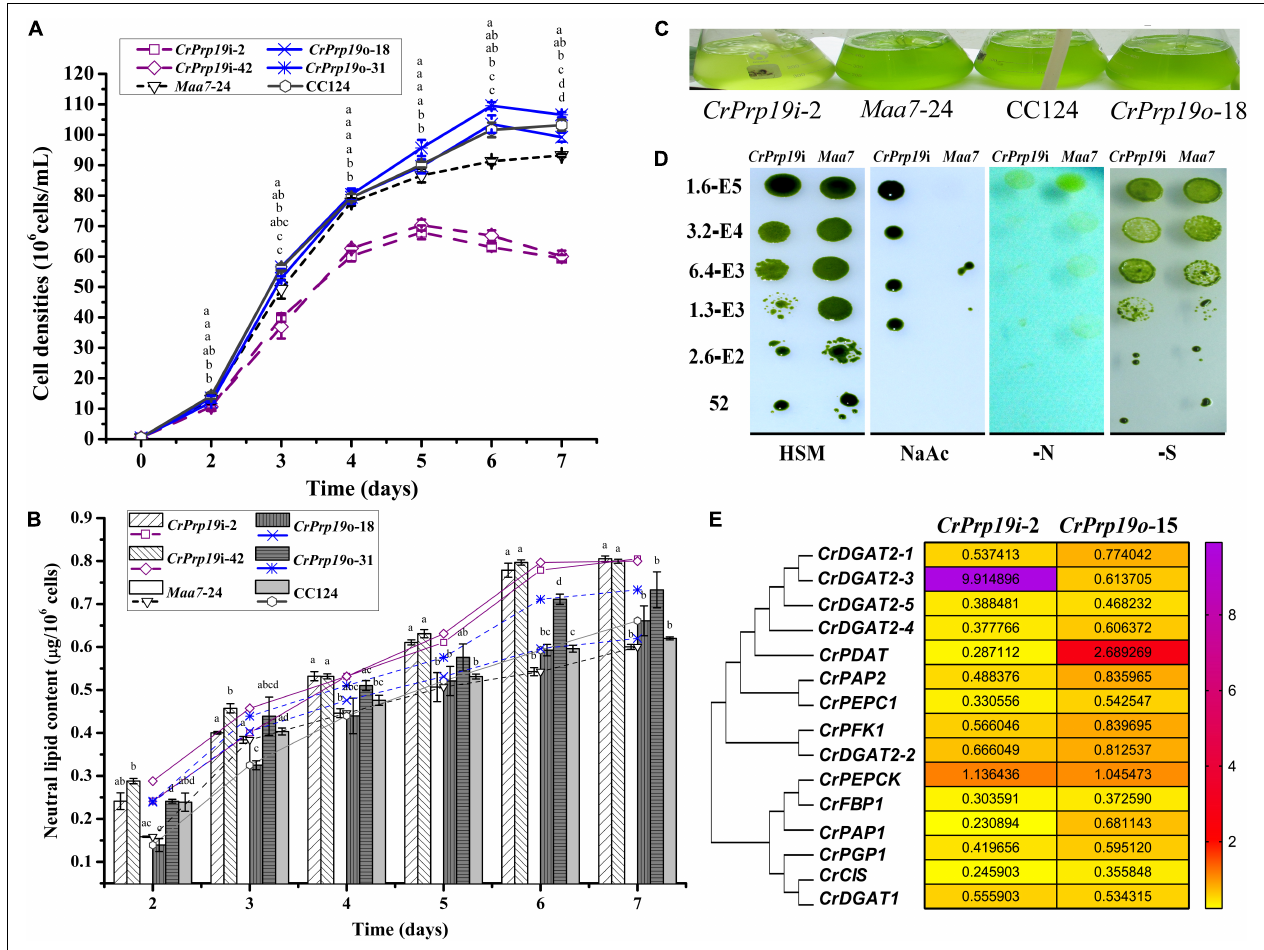
FIGURE 4 | CrPrp19 gene expression, cell growth, and NL contents of RNAi and overexpression transformants and their controls. NL contents were estimated by dividing cell density with NL concentration calculated by Nile Red fluorescent dye staining method. (A) Cell densities of CrPrp19 RNAi and overexpression lines and controls. The different letters above each point indicate that they were significantly different at p ≤ 0.05 according to one-way ANOVA. (B) NL contents of CrPrp19 RNAi and overexpression lines and controls. The different letters of each column indicate that they were significantly different at p ≤ 0.05 according to one-way ANOVA. (C) Aerated cultures of CrPrp19 RNAi and overexpression transformants and their controls. (D) CrPrp19 RNAi line ( CrPrp19 i-2) and Maa7 line grown in stress plates. (E) Heat map of mRNA expression levels of lipid synthesis–related genes in CrPrp19 RNAi and overexpression transformants, which was analyzed via qRT-PCR normalized with Maa7 line and CC124, respectively.